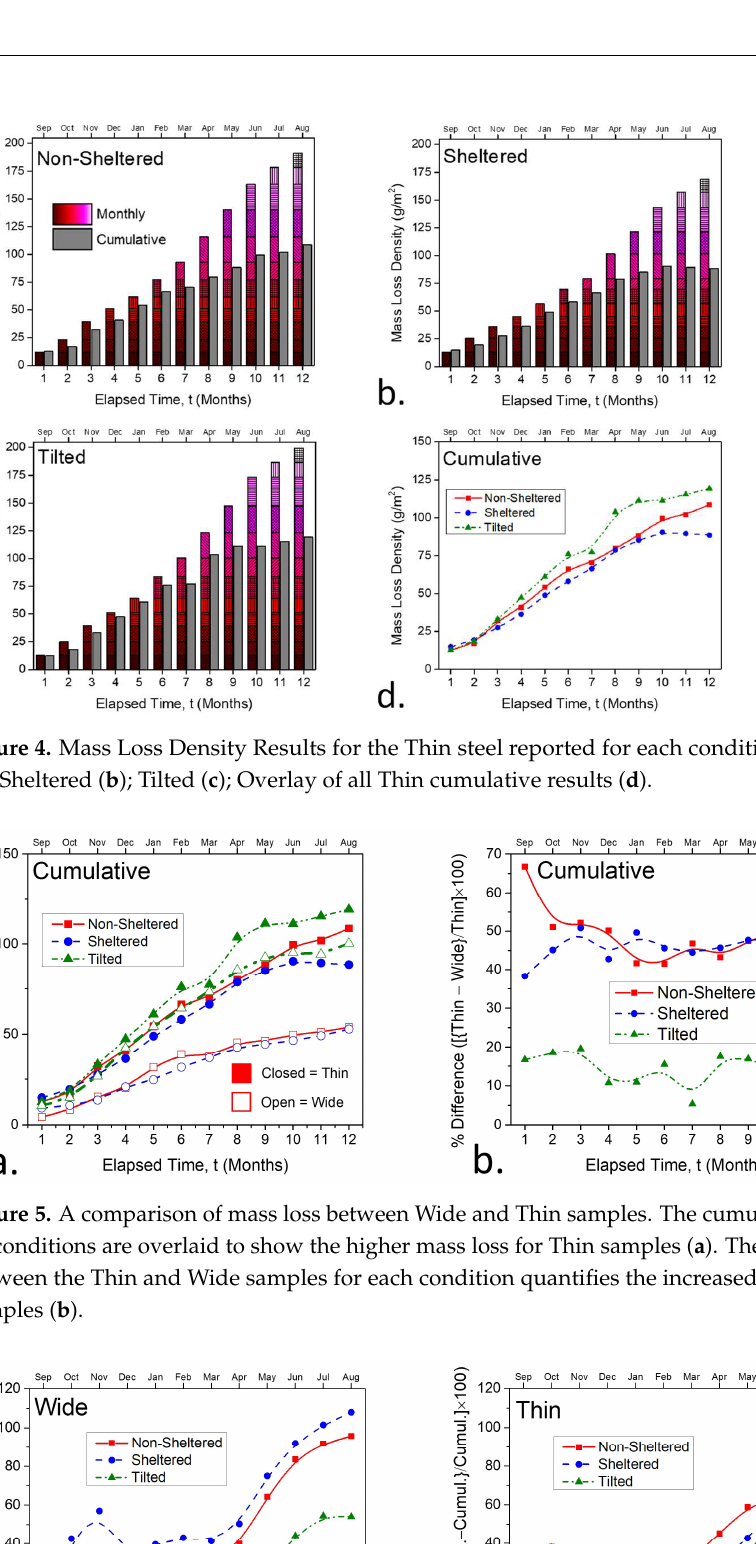
all conditions are overlaid to show the higher mass loss for Thin samples ( a ). The percent difference samples ( b ).